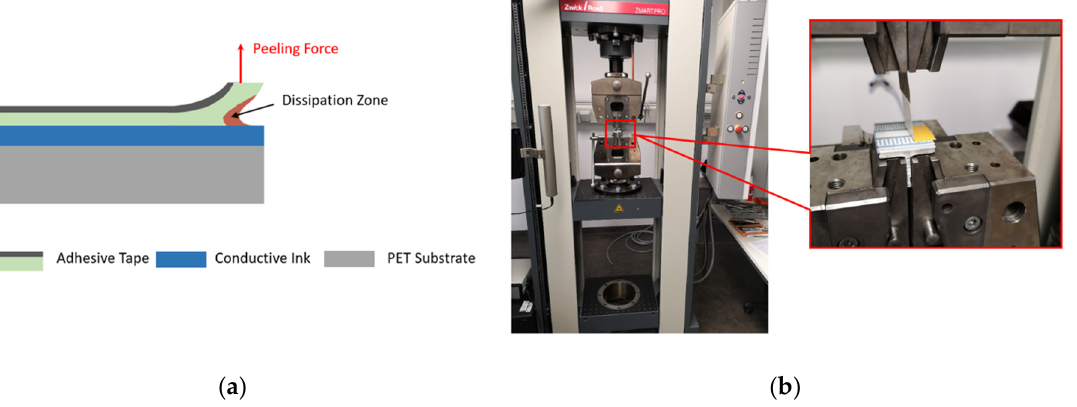
Figure 6. Schematic. ( a ) The peeling force test; ( b ) the entire device-under-test (DUT) and test machine in the laboratory.